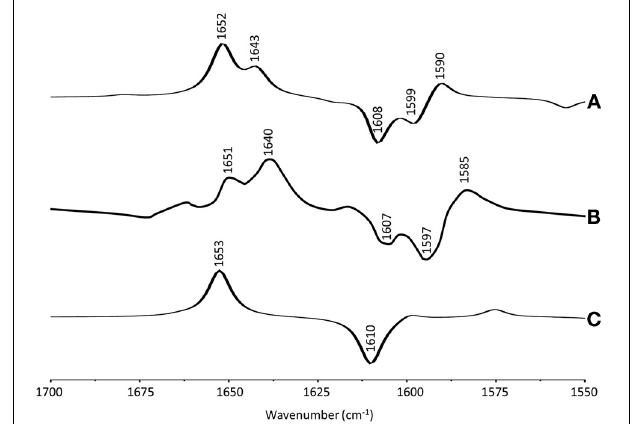
FIGURE 6 | (A) ONIOM calculated 13 C isotope edited DDS for neutral VK in the Q A binding site. Experimental spectrum is also shown (B) , taken from Breton (1997) (with permission). (C) DFT calculated 13 C isotope edited DDS for neutral VK in the gas phase. ONIOM and gas phase calculated spectra were scaled by 0.9718 and 0.9608,